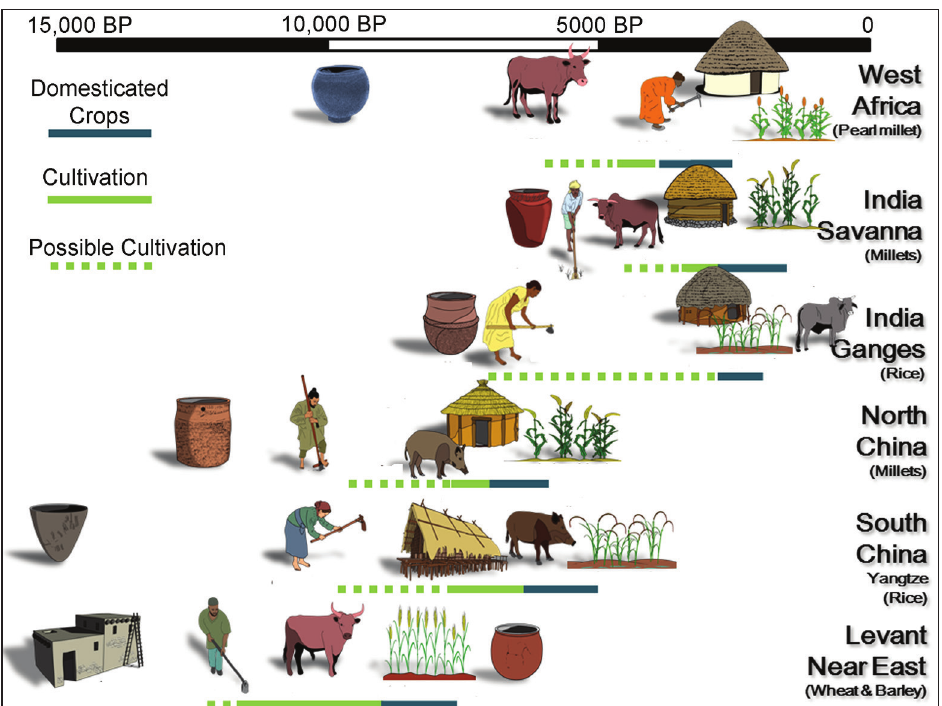
Figure 2: A comparative timeline of pathways to the ‘Neolithic’, indicating the advent of sedentism (hut icons), ceramics, animal husbandry, cultivation (pre-domestication cultivation), domestica- tion and agricultural economies (indicated by crop icons) for selected regions of the Old